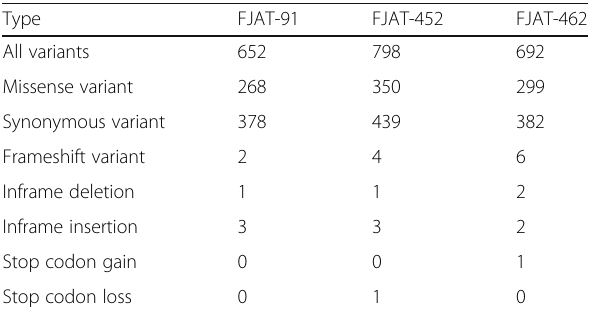
Table 9 Numbers and types of sequence variations (SNPs and INDELs) identified in the Type III effector genes (SNPs and INDELs) between the three newly sequenced strains and